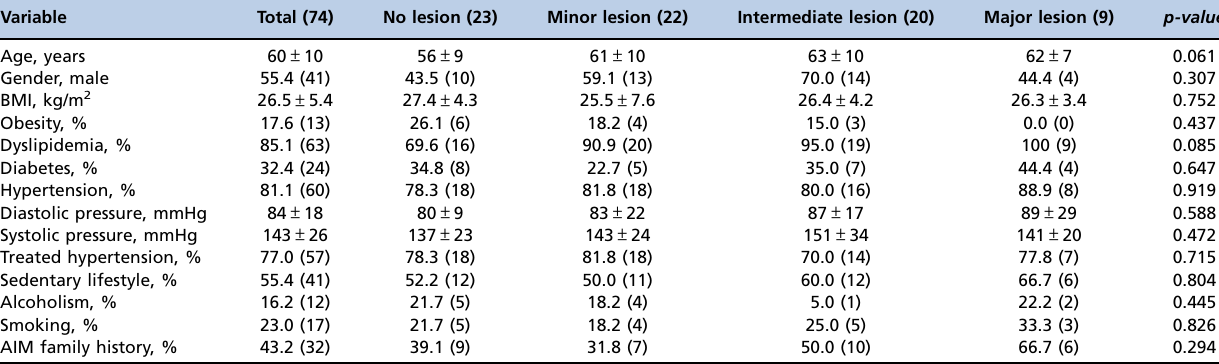
Table 1 - Demographic, anthropometric and clinical data from patients classified according to the extent of the coronary lesion. Variable